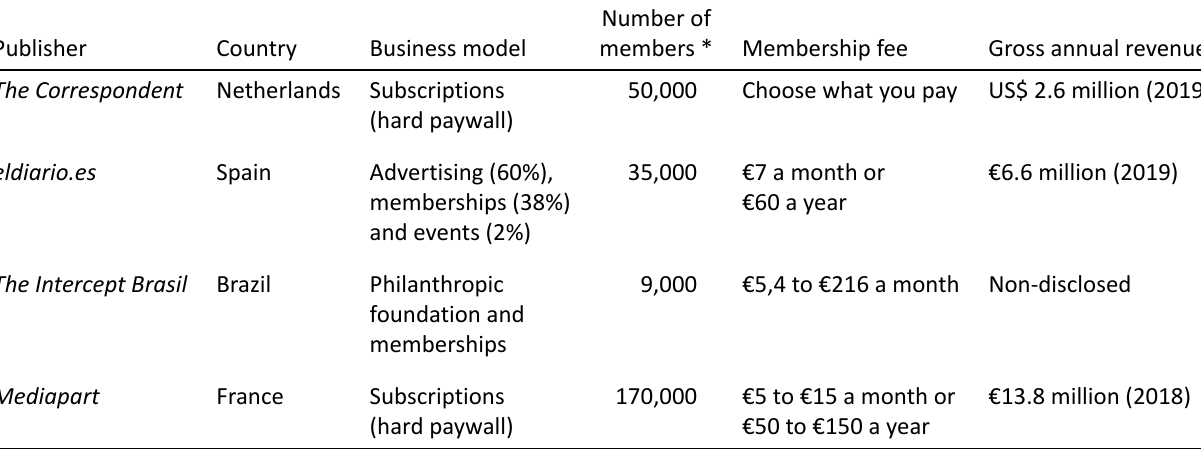
Table 2. Selection of